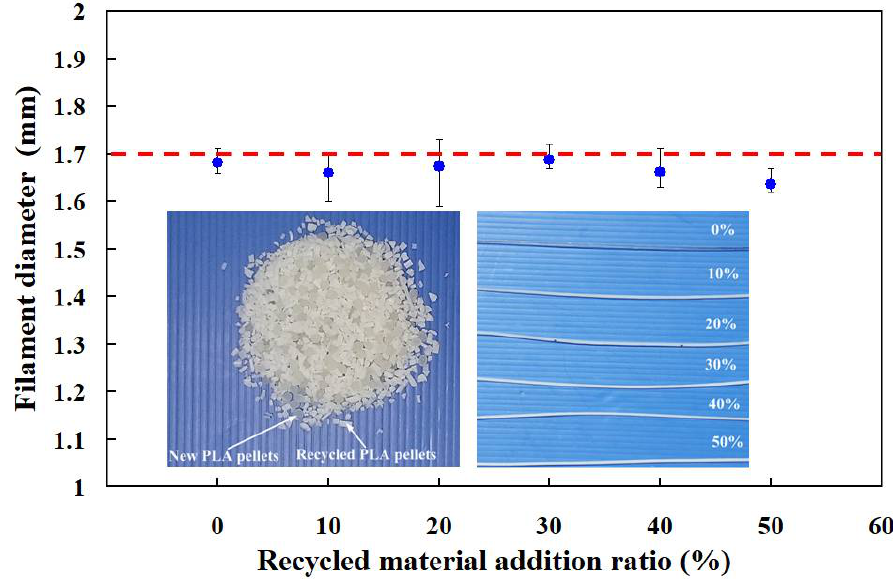
Figure 7. Effects of the recycled material addition ratios on the PLA filament diameter. Table 1. Process control factors and their levels.